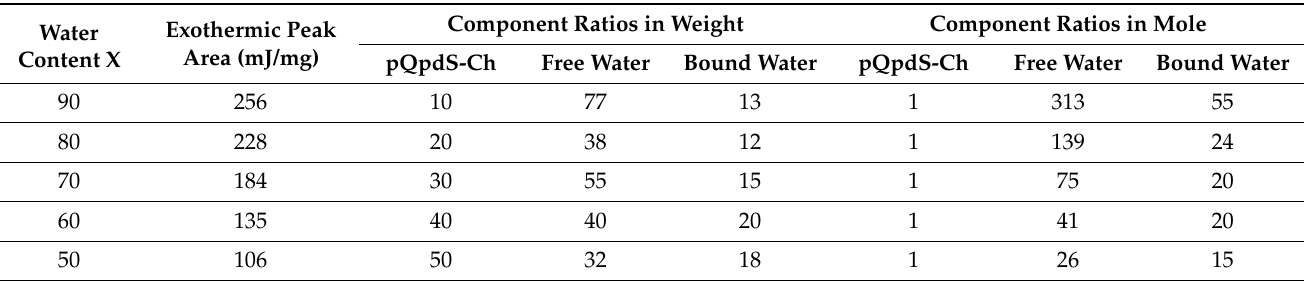
Table 1. Weight ratios and molar ratios of pQpdS-Ch , free water, and bound